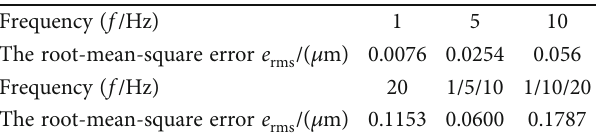
Table 4: The root mean square error of the adaptive compound control.